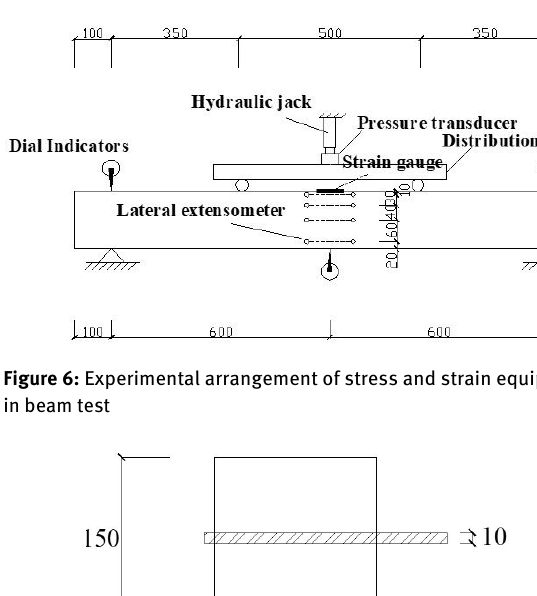
Figure 3: Mixing procedure of recycled aggregate concrete (RACs)